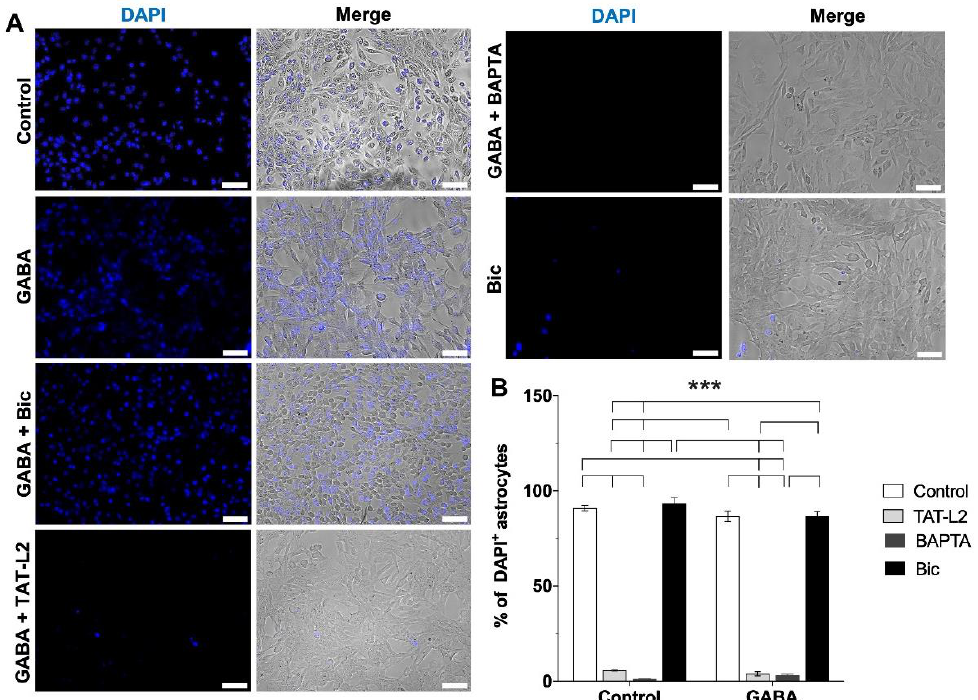
Figure 1. Increased DAPI uptake in DI TNC1 astrocytes incubated in a Ca 2+ -free solution is mediated by astroglial Cx43 hemichannels and depends on intracellular [Ca 2+ ] but is unaffected by GABA or GABA A receptor antagonist Bicuculine. ( A ) Representative photomicrographs showing increased DAPI uptake in DI TNC1 astrocytes incubated in a Ca 2+ -free culture medium. Increased DAPI uptake was blunted by 10 nM TAT-Cx43L2 (TAT-L2) or 100 nM BAPTA-AM (BAPTA), but unaffected by 1 µM GABA alone (GABA) or 100 µM bicuculline (Bic). Scale bar: 50 µm. ( B ) Quantification of DAPI uptake. n = 3, with technical triplicates. Error bars: SE; *** p ˂ 0.001.